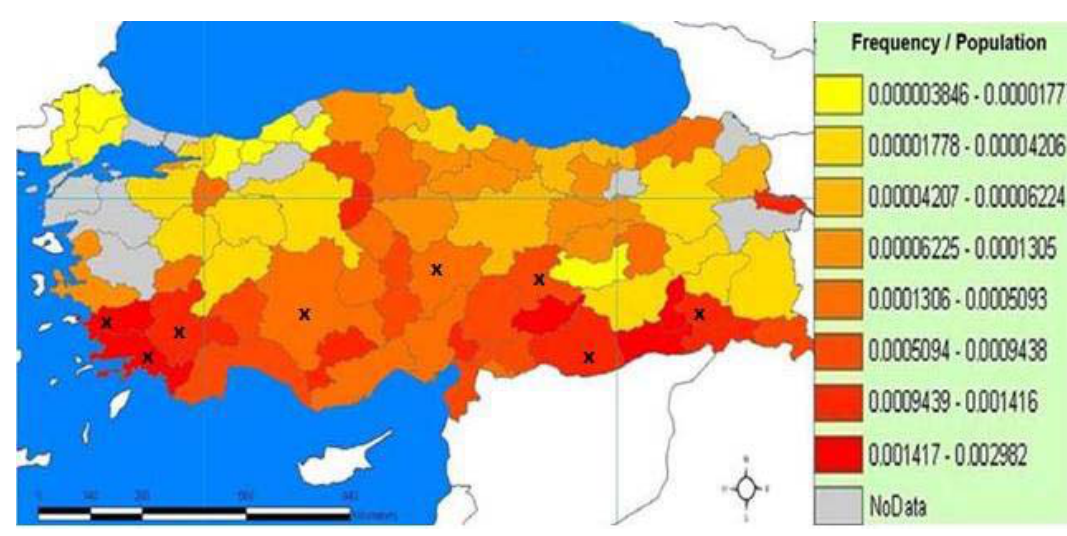
Figure 2. Overall annual incidence is about 36 scorpion stings per 100,000 inhabitants and the estimated annual mortality is 0.01 death per 100,000 inhabitants